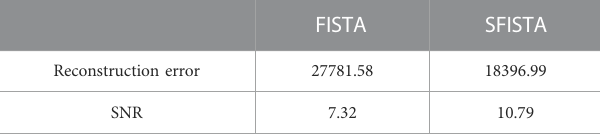
TABLE 7 Reconstruction error and SNR of different